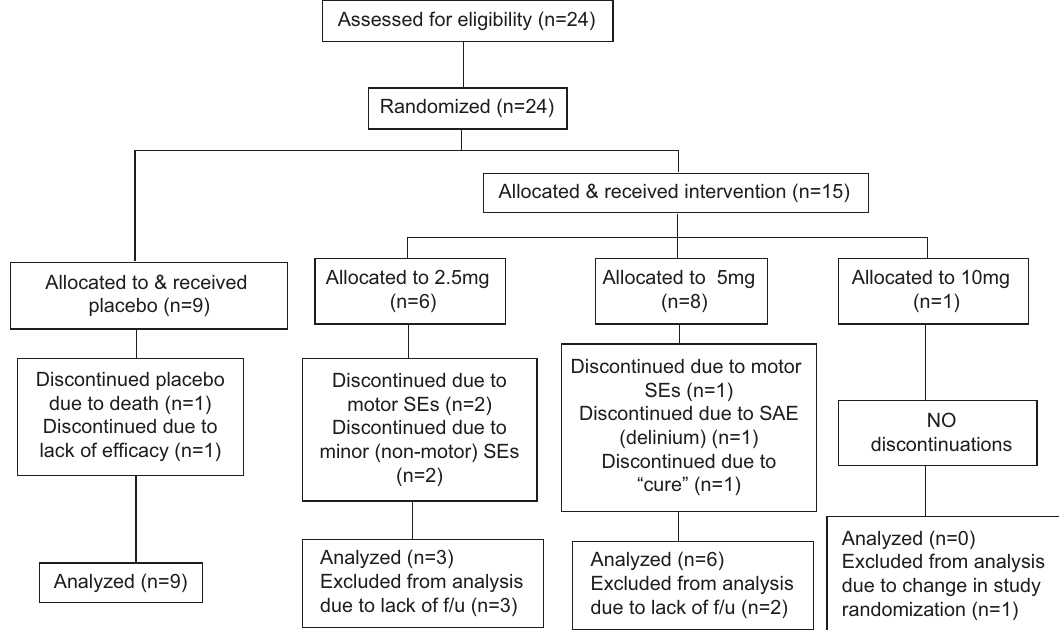
Figure 1. CONSORT